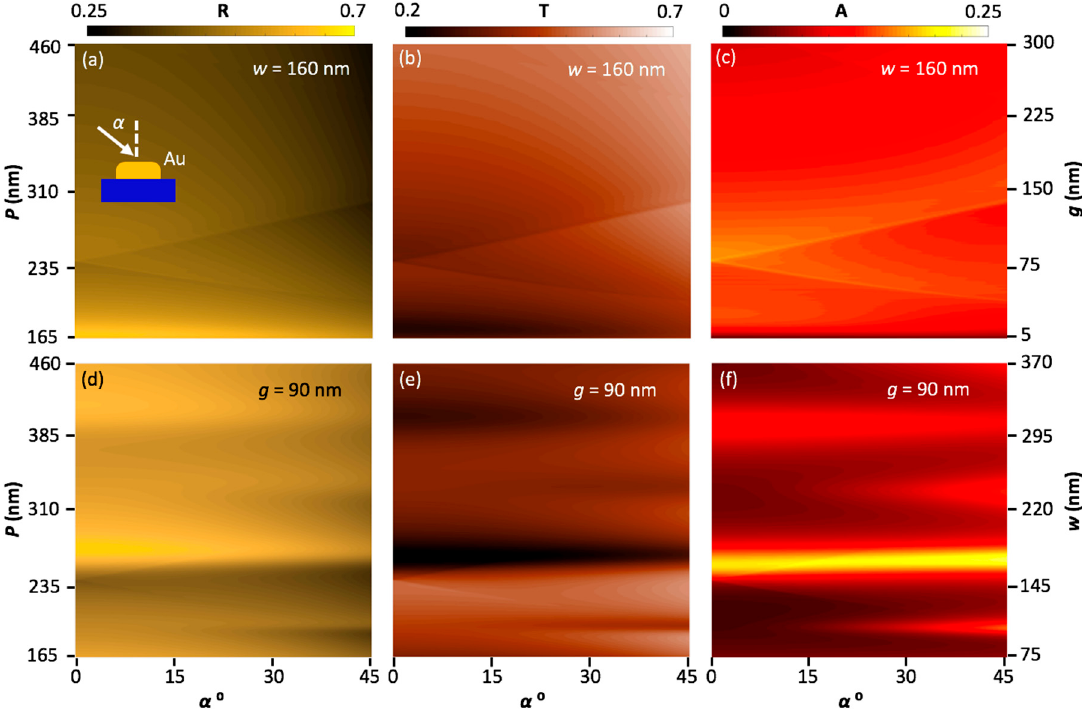
Figure 2. Color maps of reflection (R), transmission (T) and absorption (A) as a function of angle of incidence ( α ). In ( a – c ), the period was changed by varying the nano-slit width ( g ), and in ( d – f ), by varying the wire width ( w ). In ( a – c ), w and t are fixed at 160 and 15 nm, respectively, while in ( d – f ), g and t are fixed at 90 and 15 nm, respectively. Also, g , w , and α were swept from 5 to 300 nm, 75 to 370 nm, and 0° to 45° in steps of 1 nm, 1 nm, and 1°, respectively.